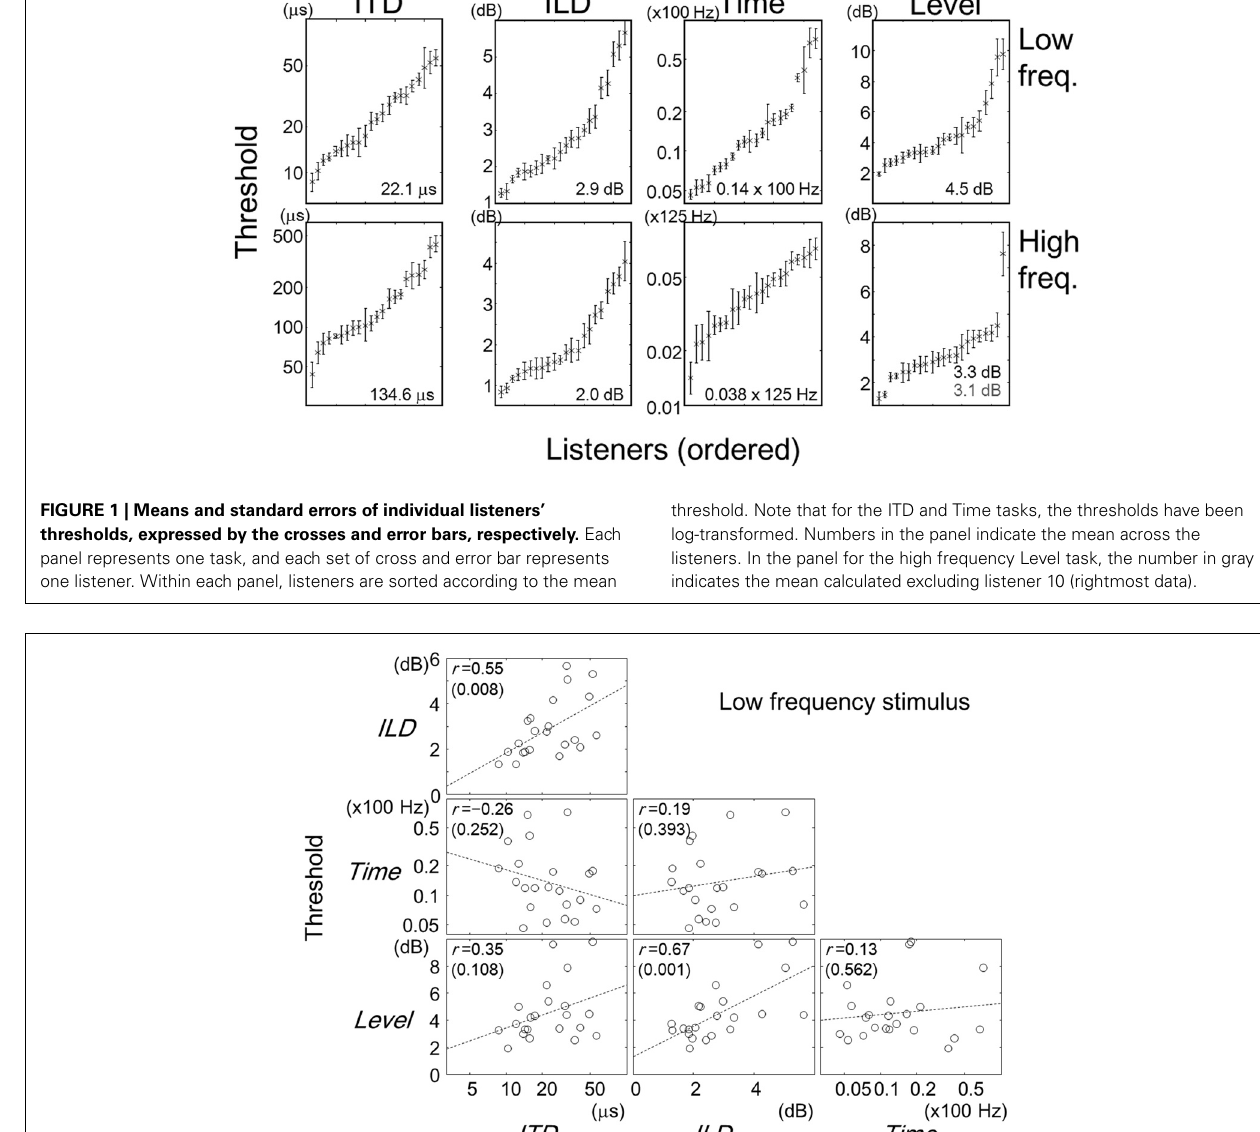
FIGURE 2 | Comparisons of thresholds between tasks for the low-frequency stimulus. Each panel represents one combination of tasks as labeled. Each symbol represents one listener. The broken lines are best-fit straight lines to the data. The Pearson correlation